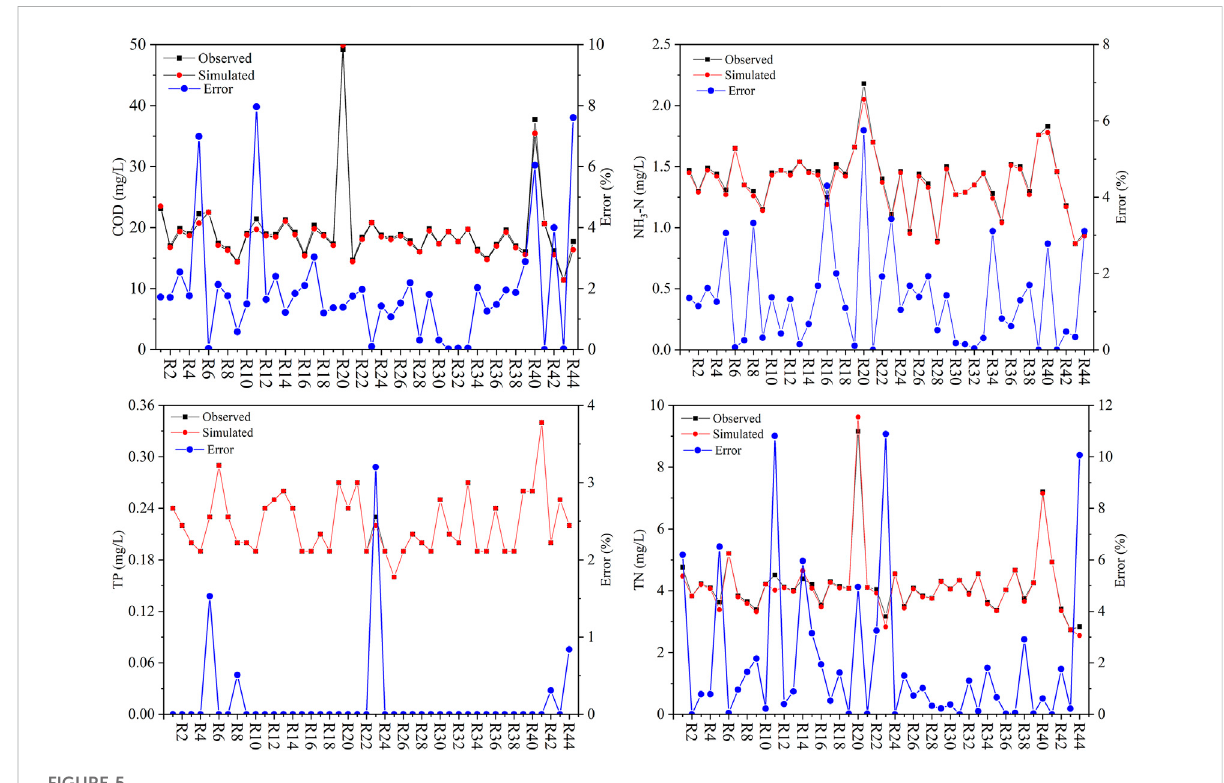
FIGURE 5 Water quality concentration simulation and error analysis of